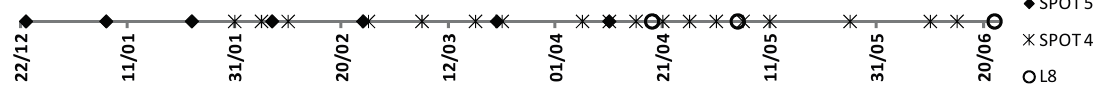
Figure 3. Time series of satellite images Spot4-Take5, Spot5 and Landsat8 during the 2012/13 season. Landsat8 scenes were not used during the experiment and are only indicated as reference. The gaps in the SPOT4 series are only due to cloud